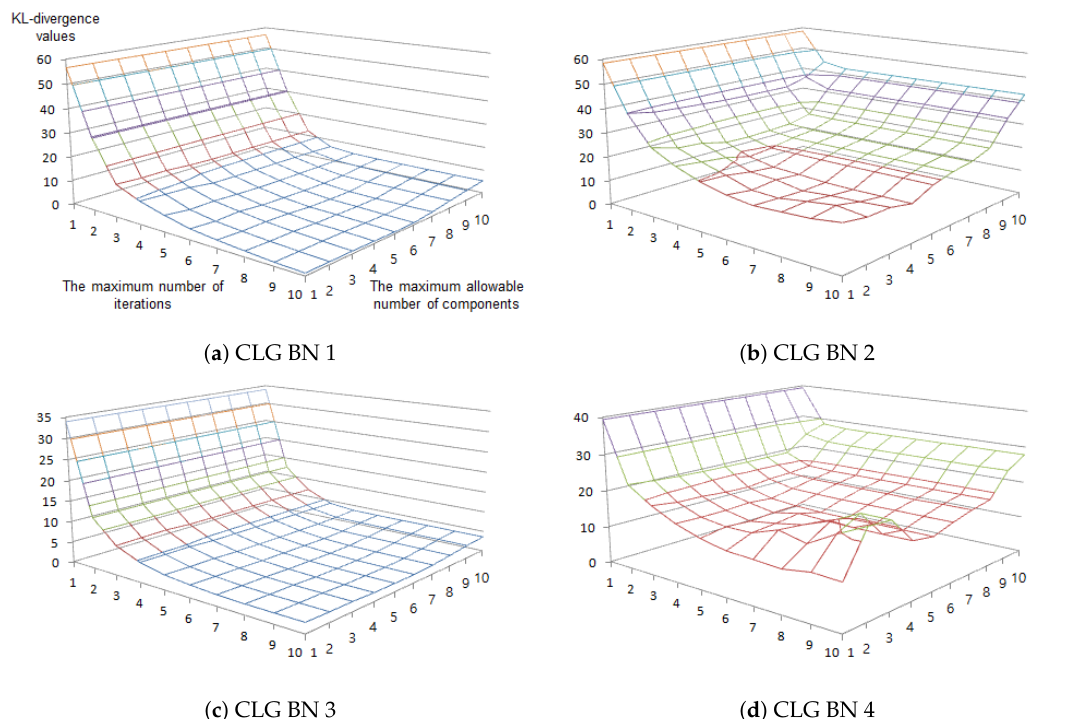
Figure 8. Accuracy as a function of maximum allowable numbers of components and maximum iterations for four CLG BNs.